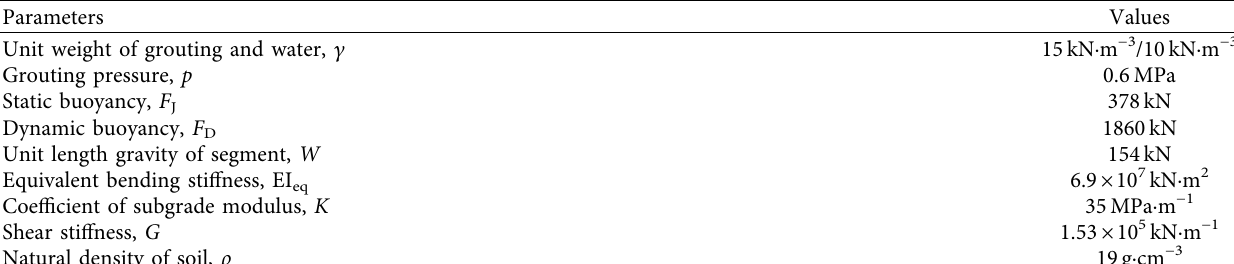
Table 3: The model parameters.